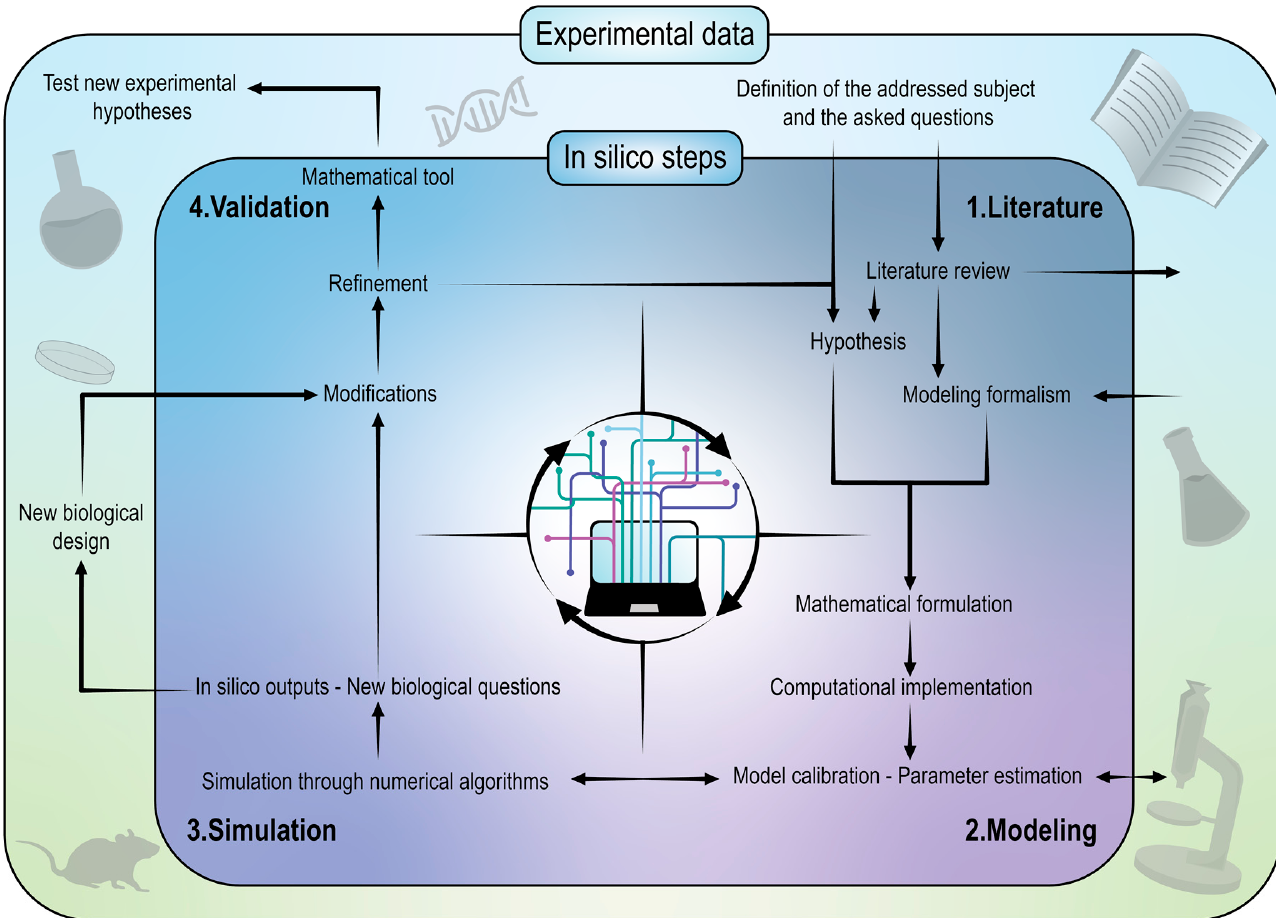
Figure 3. The mathematical modeling pipeline in biology. The in silico procedure is divided into 4 distinct steps, including literature, modeling, simulation, and validation. During this entire modeling process, the symbiotic approach comparing in vitro and in vivo experimental data with computer outputs is used.